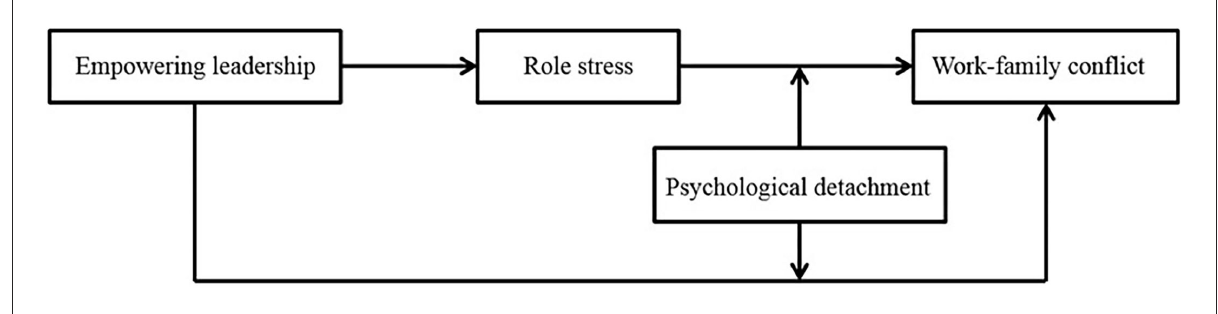
FIGURE1 The moderated mediation model of leadership “black